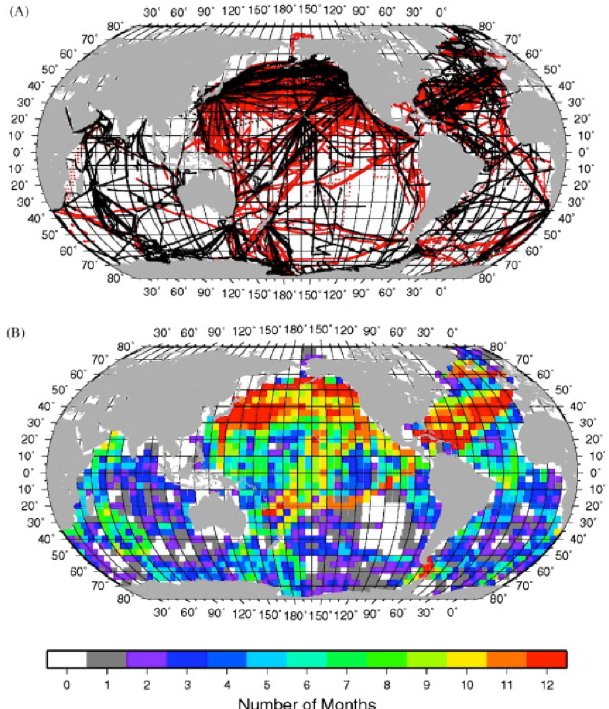
Fig. 2. The upper figure shows the location of observations of oceanic p CO 2 . Black dots indicate the database ( ∼ 1million p CO 2 measurement) used for Takahashi et al. (2002); and red dots in- Figure 2 The upper figure shows the location of observations of oceanic pCO 2 . Black 1193$ dicate an additional ∼ 3million data points used for Takahashi et dots indicate the database (~1 million pCO 2 measurement) used for Takahashi et al. 1194$ al. (2009). The lower panel shows the number of months of the year (2002); and red dots indicate an additional ~3 million data points used for Takahashi 1195$ for which observations exist. This data is the basis of the obser- vational data used in this study (reproduced from Takahashi et al., et al. (2009). The lower panel shows the number of months of the year for which 1196$ observations exist. This data is the basis of the observational data used in this study 1197$ (reproduced from Takahashi et al, 2009). 1198$